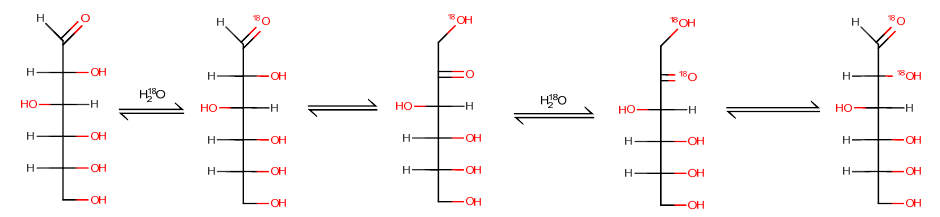
Figure 2. A possible explanation of additional 16 O/ 18 O exchange usingD-glucose as an example.